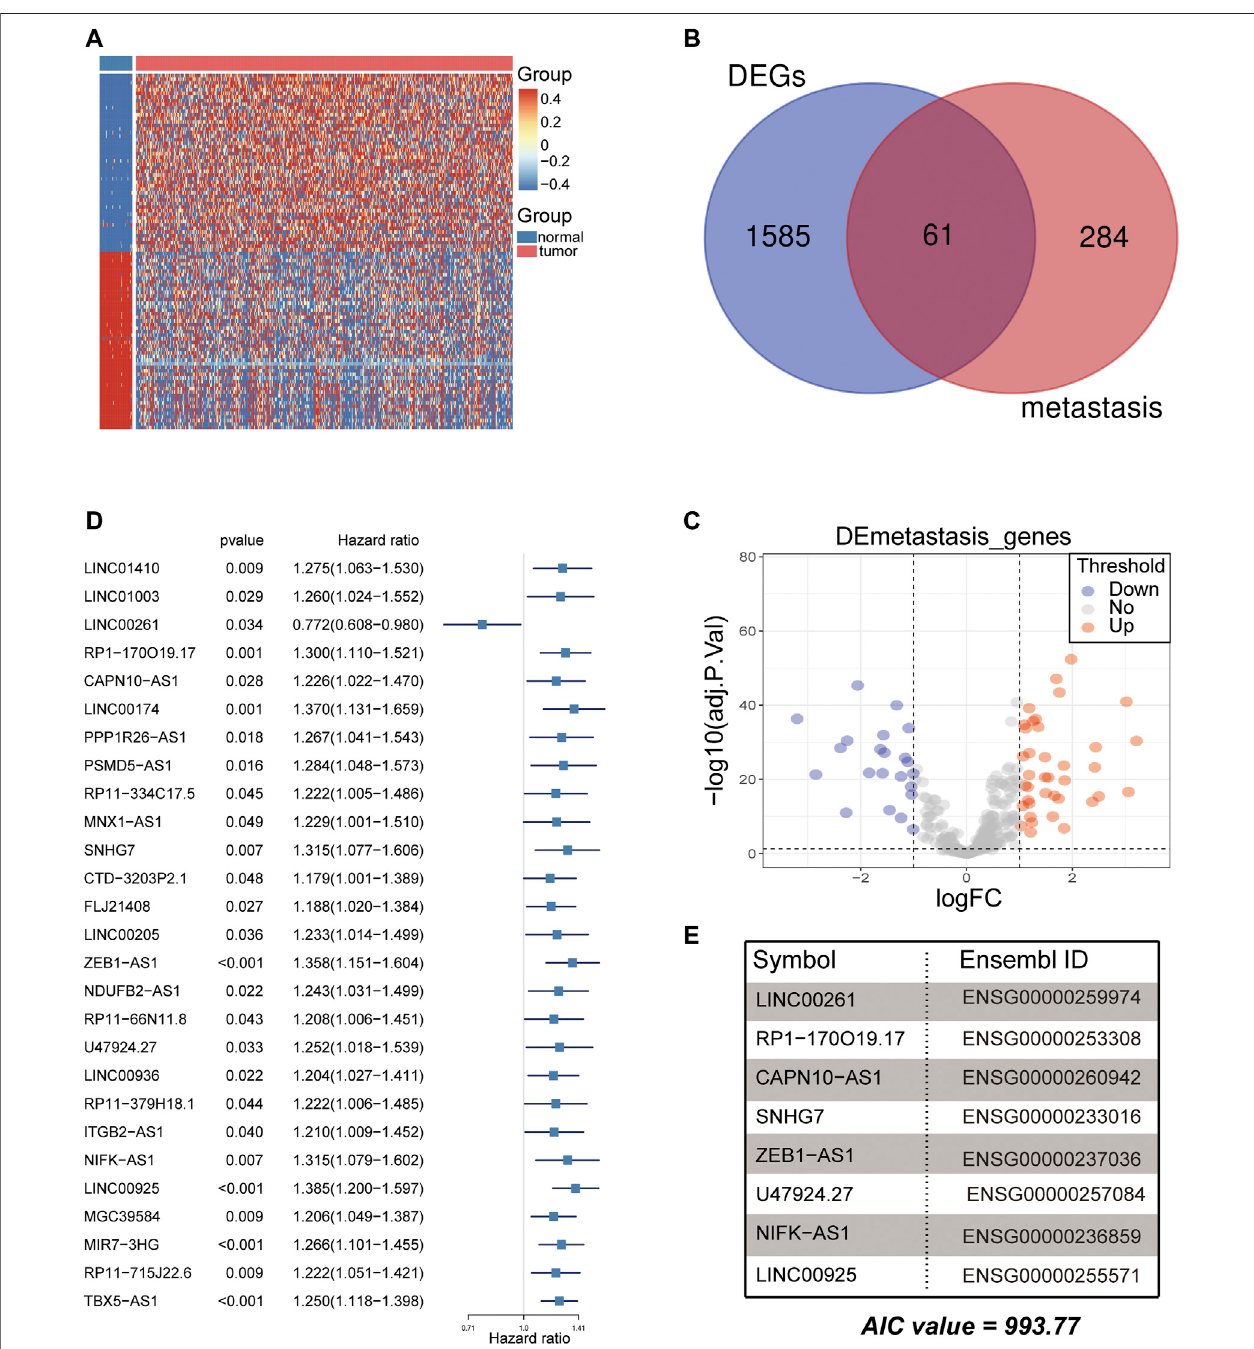
FIGURE 2 | Analysis of differentially expressed metastasis-related genes for CRC. (A) Heatmap of the top 100 differentially expressed genes (DEGs) between normalandCRCtumorsamplesintheTCGAcohort. (B,C) TheVennplotandvolcanoplotshowedthat61metastasis-relatedgeneswereobtainedintheTCGAcohort. Each red dot shows an upregulated gene, and each blue dot shows a downregulated gene (|Log2 Fold Change| > 1 and p < 0.05). (D) Twenty-seven lncRNAs were screened for prognostic signi fi cance using univariate Cox regression. (E) Eight metastasis-related lncRNAs were used to develop the signature using multivariate Cox regression (AIC value =